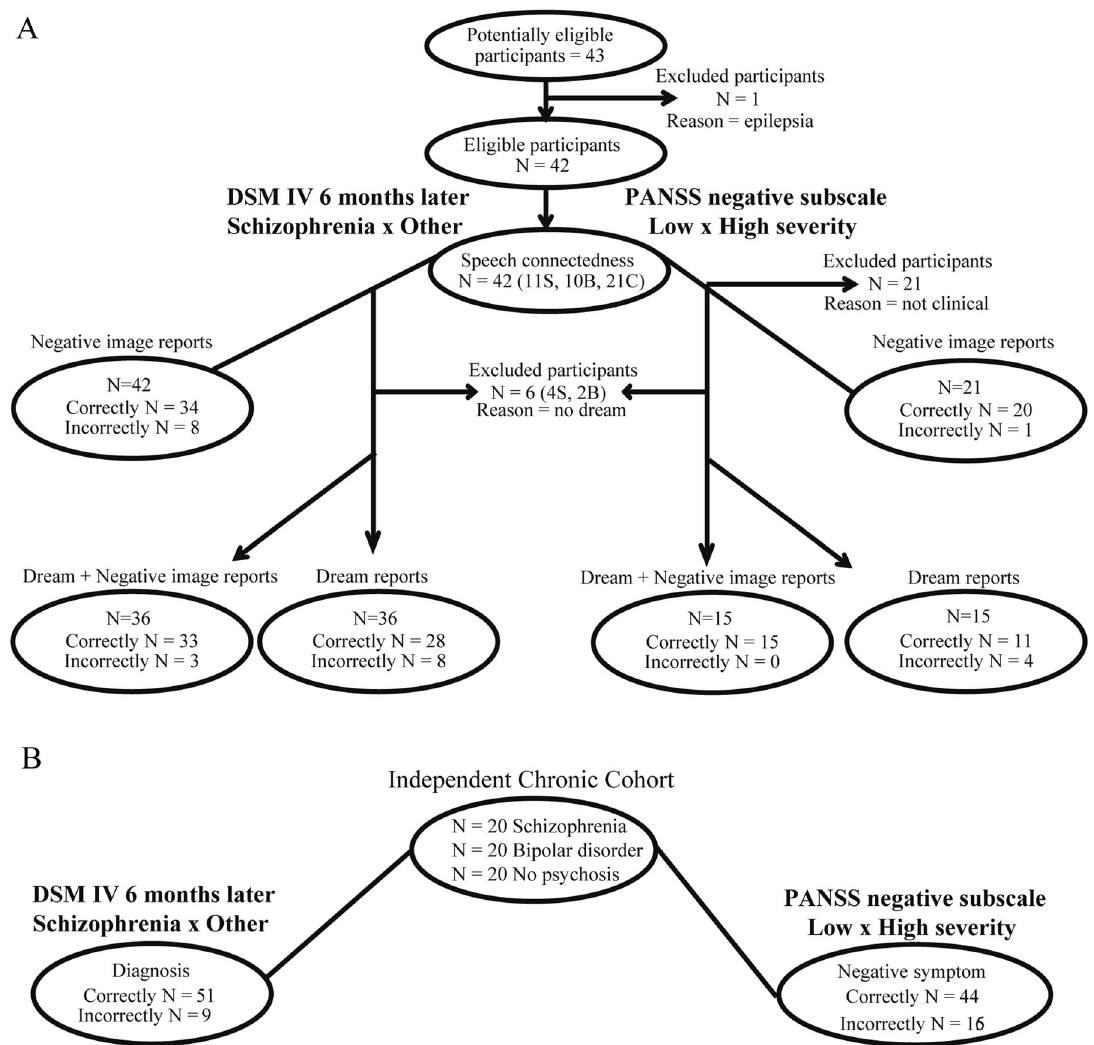
Fig. 1 Illustrative diagrams of the fl ow of participants. a Using Dream + Negative image reports or only Negative image reports, or only Dream reports. Control subjects were excluded from positive and negative syndrome scale (PANSS) analyses because they were “ not clinical ” , i.e., they were not at clinical settings. c Through the validation in an independent cohort of chronic psychotic patients. Schizophrenia (S), Bipolar b and Control c